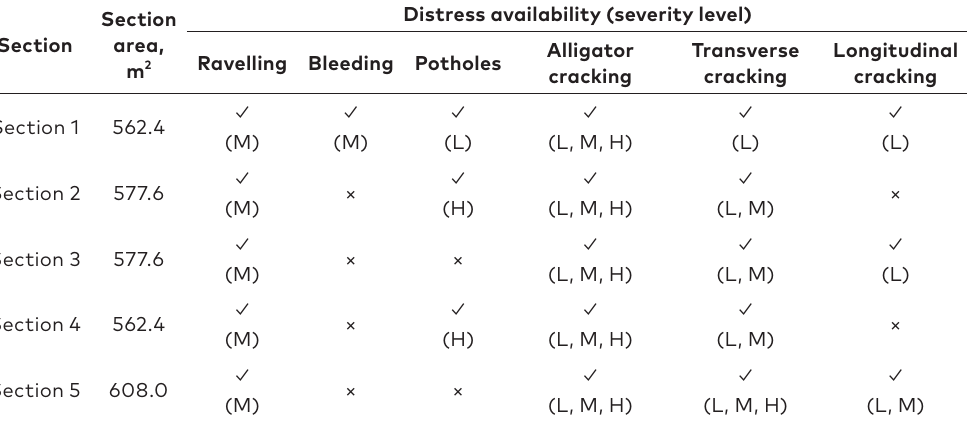
Table 4. Extracted pavement sections from LTPP with their area, location, and distress availability.